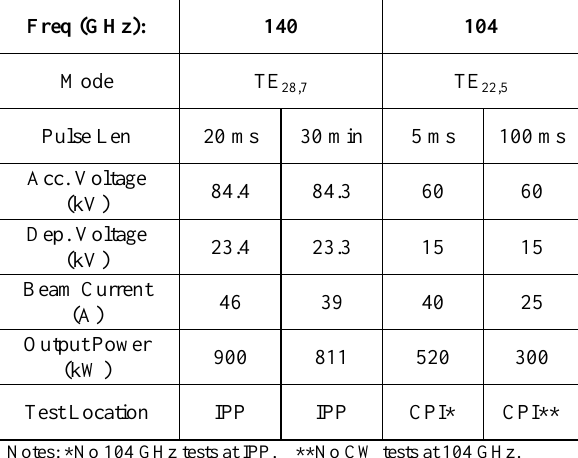
Table 1. Gyrotron Test Results.